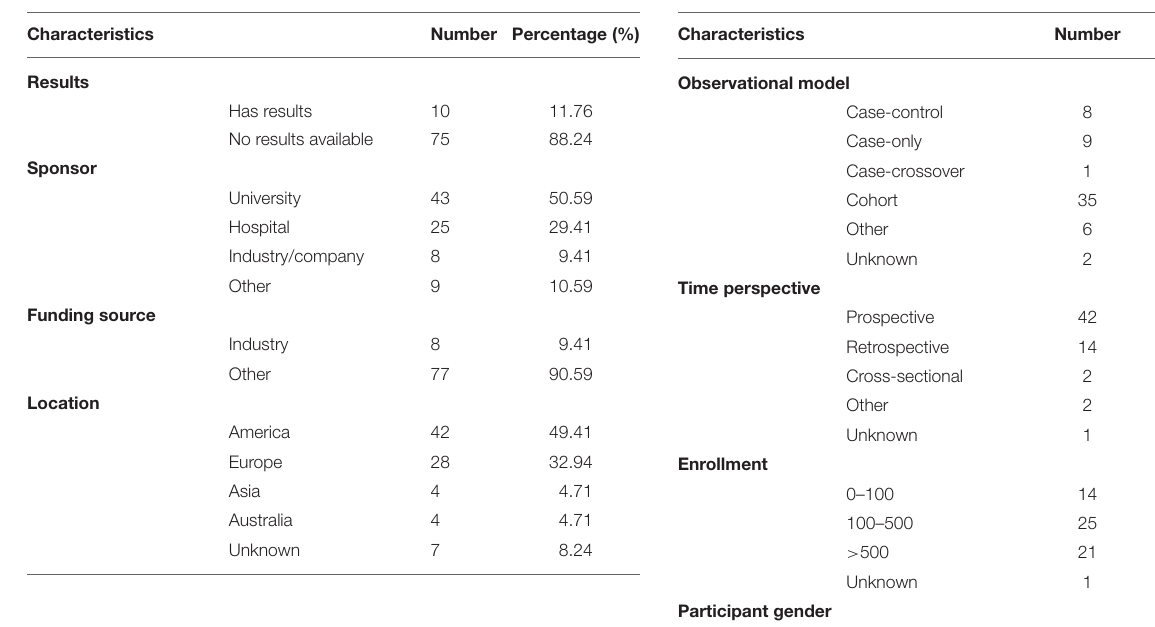
TABLE 3 | Designs of 61 observational trials registered on